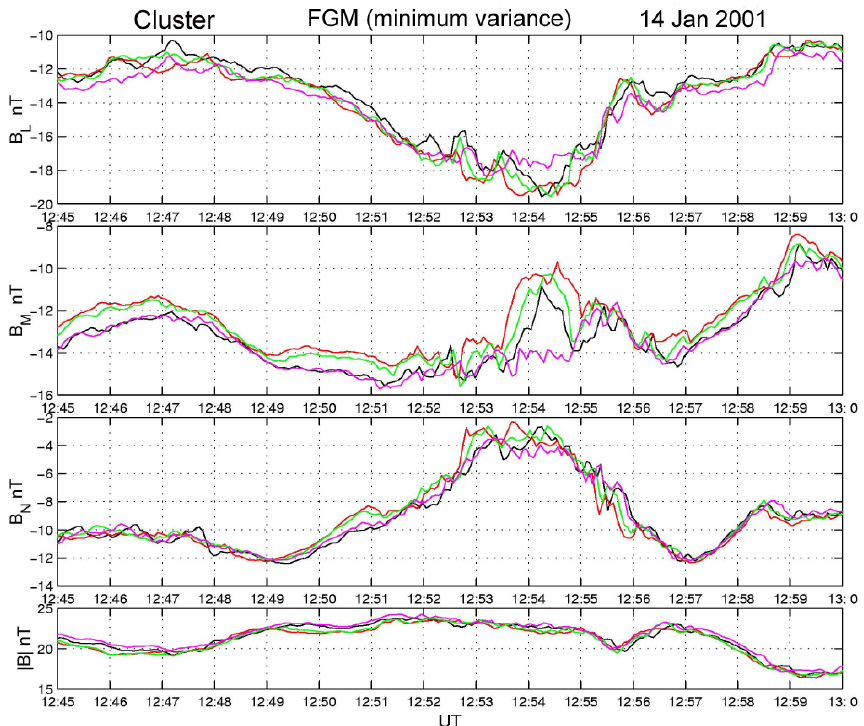
Fig. 14. The same as Fig. 11, for the interval